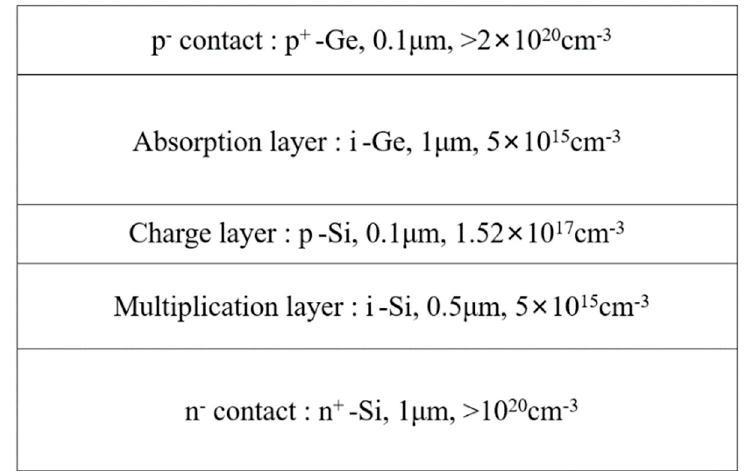
Figure 12. Layer structure for separate-absorption-charge-multiplication (SACM) Ge/Si APD. To improve the device’s performance, several modifications had been made to the above-mentioned APD structures (Figure 13). First, the i-Si multiplication region was in- creased to 1.0 μ m, which will raise the voltage difference between the avalanche break- down voltage and punch-through voltage. Then, the doping concentration for the p-Si charger layer was designed in the range of 1 × 10 17 cm − 3 to 5 × 10 17 cm − 3 . As punch-through voltage depends merely on the doping concentration of the charger layer, one can alter the voltage difference by changing the doping level. Especially at low temperatures, small voltage differences will remarkably lower the SPDE for APD at 1.31 μ m and 1.55 μ m. To characterize the low-temperature performance, APD devices were mounted in the liquid nitrogen (LN 2 )-cooled cryostat. Both pulsed semiconductor lasers were employed to eval- uate the SPDE at wavelengths of 1.31 μ m and 1.55 μ m [68]. With the illumination of a 1.31 μ m pulsed laser, low temperature (100 K) SPDE is approximately 4% at 10% excess bias. However, low temperature SPDE (at the wavelength of 1.55 μ m) was measured to be 0.15% at 6% excess bias, which is mainly due to the reduced absorption edge for Ge at low temperatures. At the temperature of 150 K, DCRs of 10 6 –10 7 Hz were clearly observed, which is still several orders of magnitude higher than InGaAs/InP planar SPADs (10 2 –10 3 Hz). These high DCRs were attributed to the high dark currents due to the high defect level in the Ge absorption layer and narrow bandgap of Ge. Moreover, sidewall surface recombination was also responsible for the high dark current. Si:n++(5 × 10 19 )substrateSi:i (1 × 10 15 ) 1000nm Si:p (1-5 × 10 17 ) 100nmGe:i (~1 × 10 15 ) 1000nmGe:p++ (5 × 10 19 ) 100nm Ni/Al